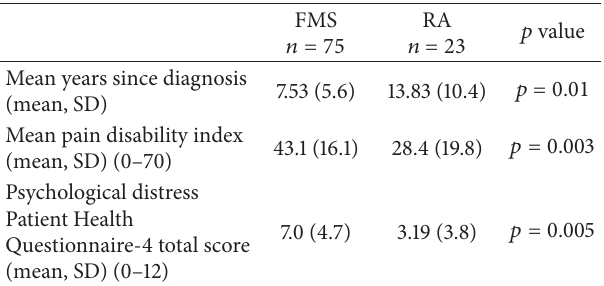
Table 4: Comparison of psychological distress of Patient Health Questionnaire score for Israeli FMS patients and RA patients.